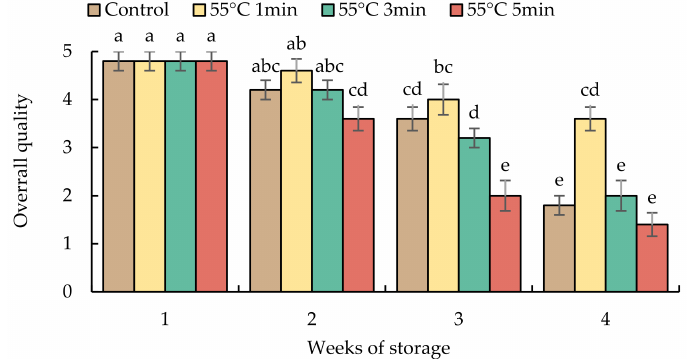
Figure 4. Effect of hot water treatment (55 ◦ C for 1, 3, 5 min) on overall quality in red sweet pepper fruit during storage at 10 ◦ C. Data represent means ± S.E. (n = 3). Different letters on bars are significantly different ( p <